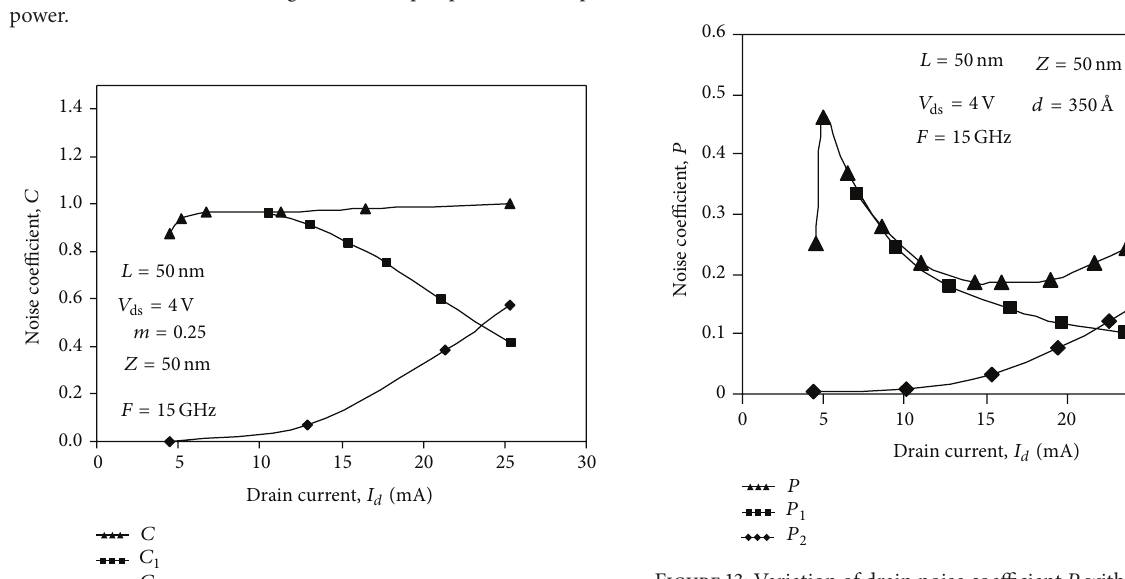
Figure 13: Variation of drain noise coefficient 𝑃 with drain